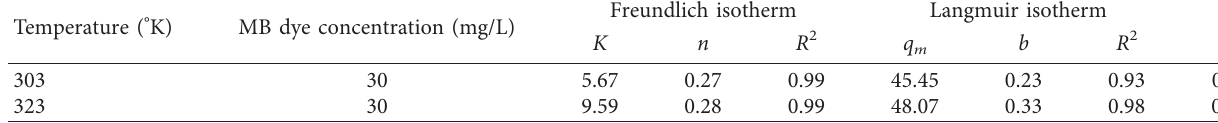
Table 1: Freundlich and Langmuir adsorption isotherm parameters.